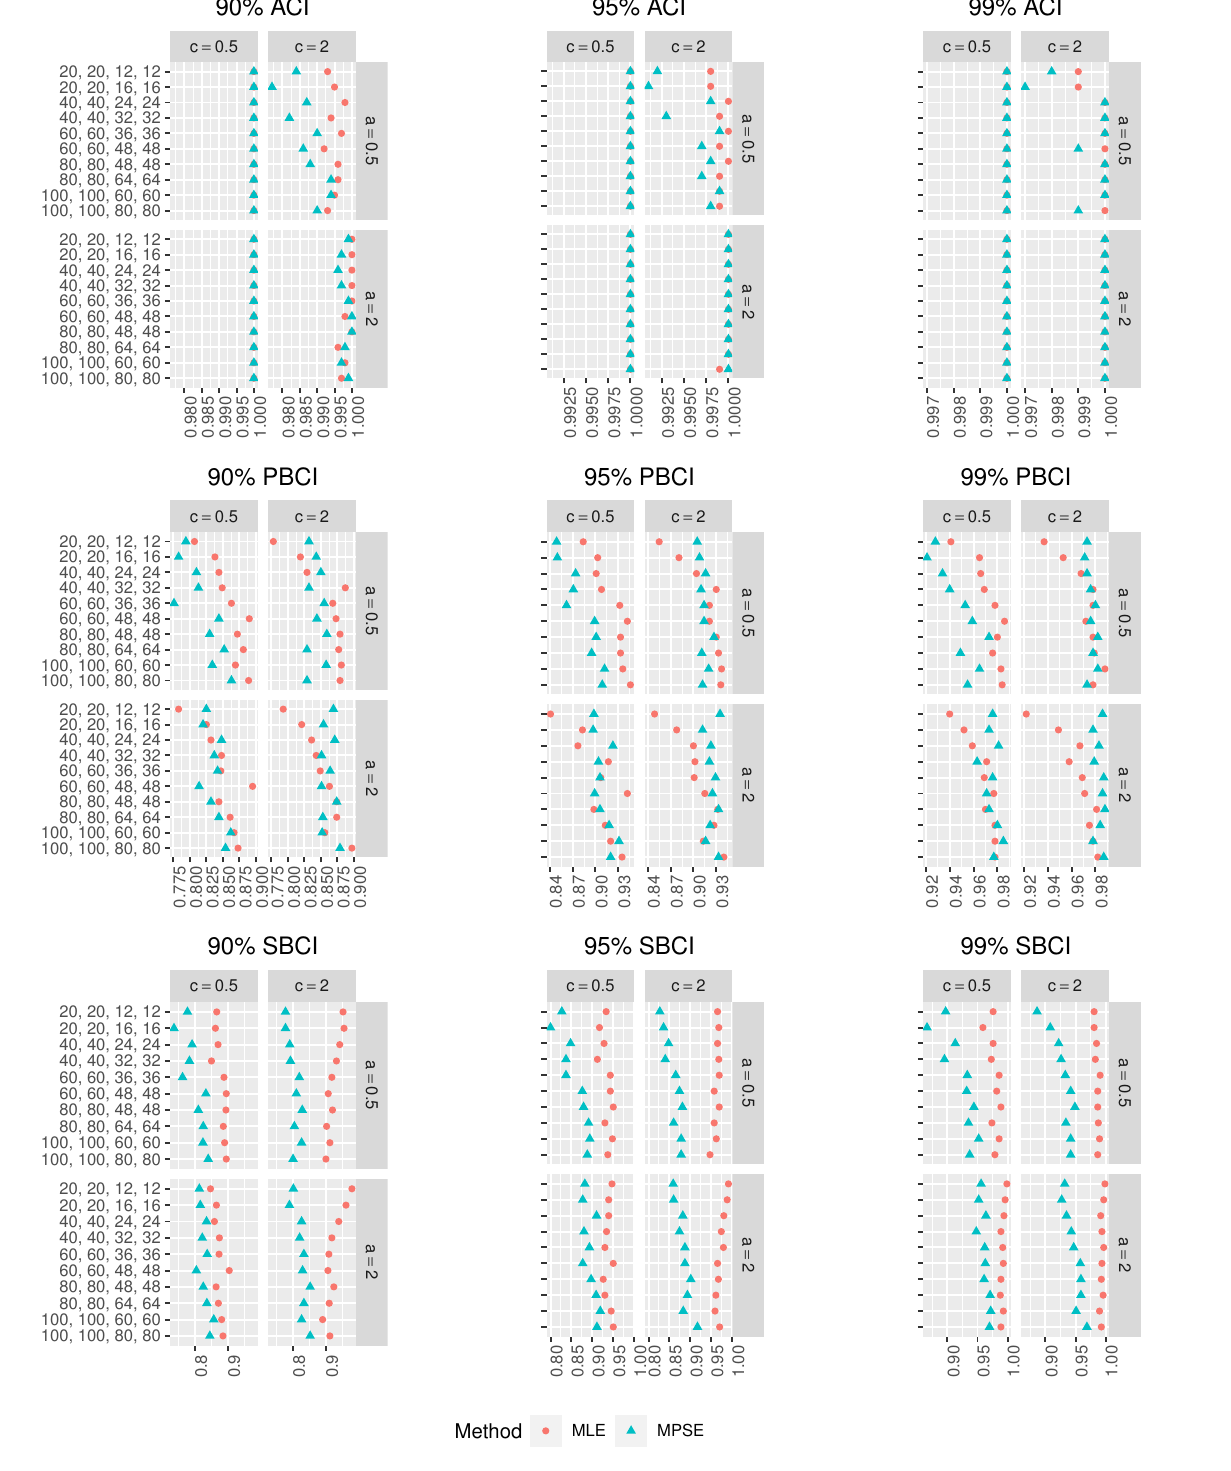
Figure 10. Simulated CPr of different CIs of c